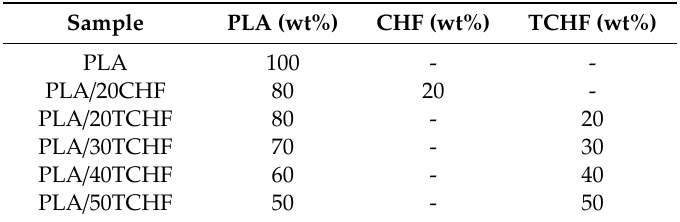
Table 1. Set of samples prepared according to the weight percentage (wt%) of polylactide (PLA), coffee husk flour (CHF), and torrefied coffee husk flour (TCHF).